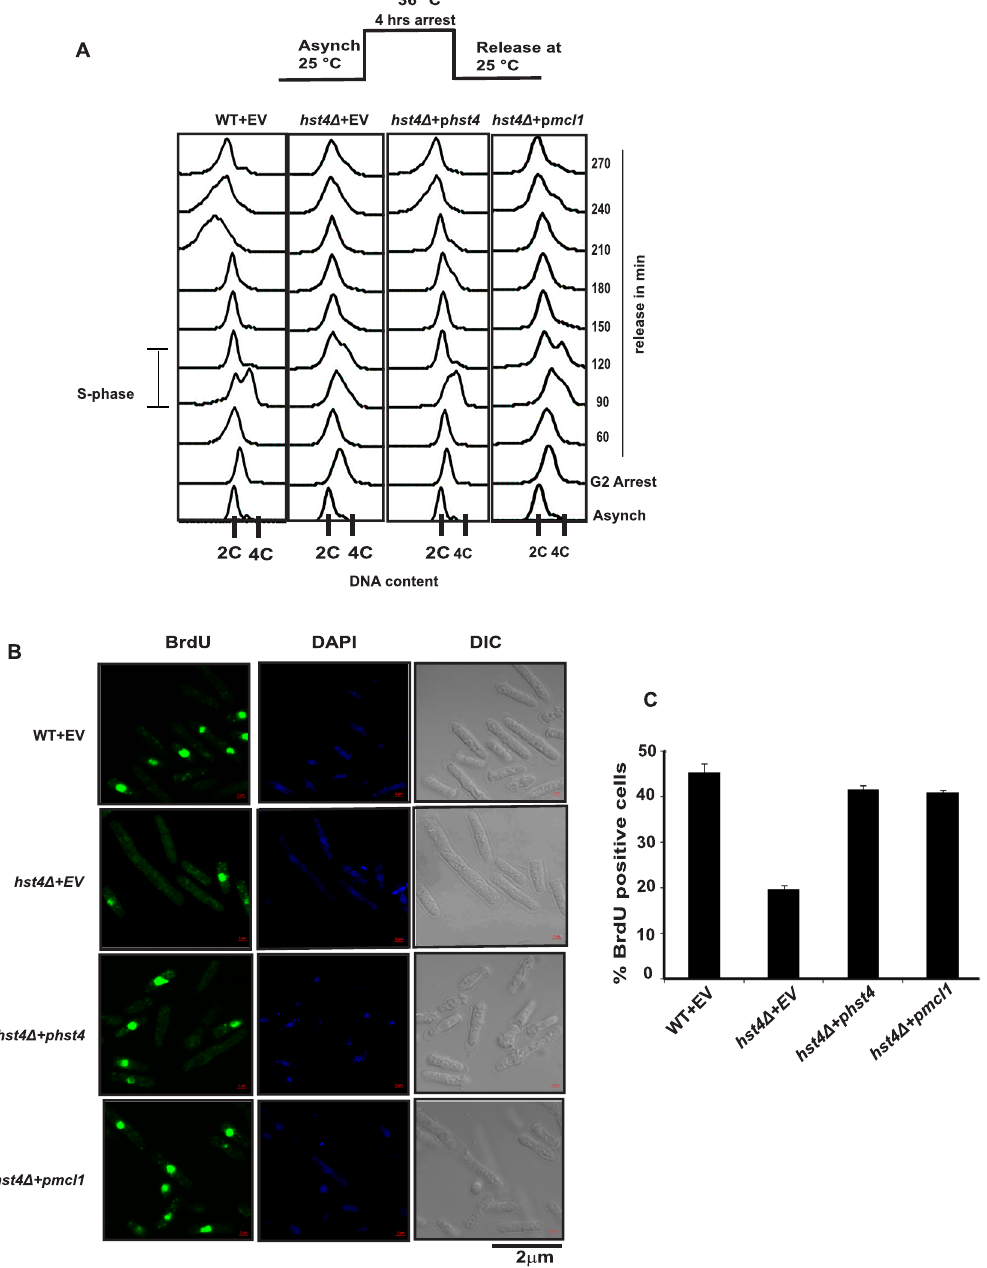
Figure 4. The rescue of S phase delay phenotypes of hst4 Δ mutants is partly dependent on Mcl1. ( A ) Flow cytometry showing cell cycle progression of wild type (WT) and hst4 Δ mutants synchronized at G2/M phase. The cdc25 - 22 mutant strain (FY4225) and cdc25 - 22 hst4 Δ (DHP56) expressing hst4 , mcl1 or pSLF272 (empty vector) were grown in EMM-URA medium to log phase at permissive temperature (25 °C) and shifted to restrictive temperature (36 °C) for 4 hr inducing G2/M arrest, cells were collected every 30 minutes and cell cycle profile was analyzed by flow cytometry. ( B ) Asynchronously growing wild type (FY4225) and hst4 Δ (DHP56) expressing hst4 , mcl1 or pSLF272 (empty vector) were grown in presence of BrdU (150 μ g/ml) for 30 minutes. Cells were fixed and stained with anti-BrdU antibody and visualized under fluorescent microscope. Bar = 2 μ m. ( C ) Quantification of the immunofluorescence data presented in (B). The percentage of S-phase cells was determined by counting BrdU positive cells. Plotted are the mean values from three independent experiments. Error bars indicate mean ±